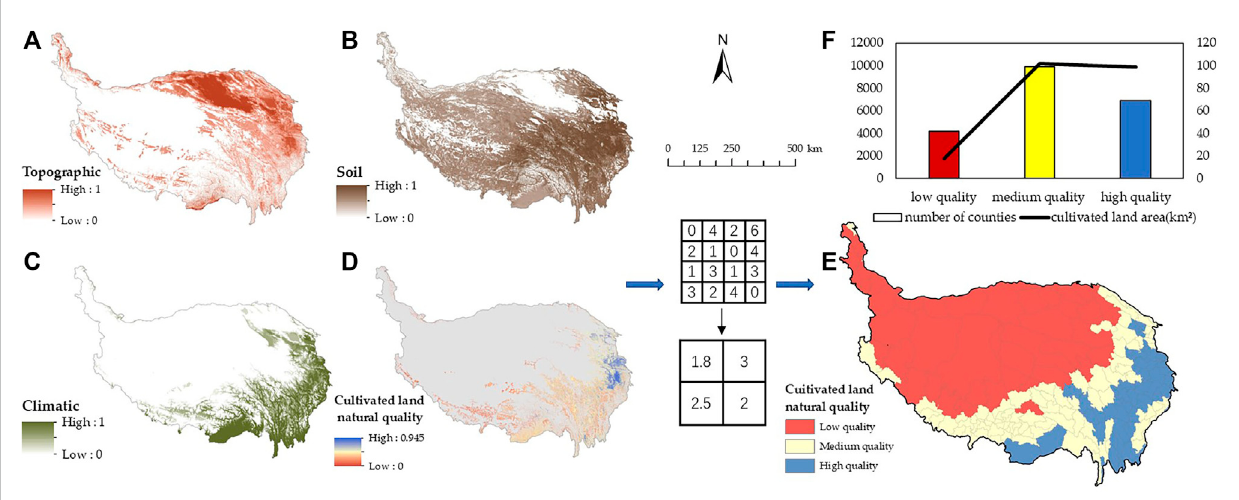
FIGURE 4 ThedivisionprocessandresultsofthenaturalbackgroundqualityofcultivatedlandatthecountyscaleontheQinghai-TibetPlateauis: (A) theresult ofterrainfactorevaluation; (B) theresultofsoilfactorevaluation; (C) theassessmentresultofclimatefactors; (D) theresultofcomprehensiveevaluation; (E) the result of the processed county scale evaluation; and (F) the number of counties and cultivated land area involved under different natural quality